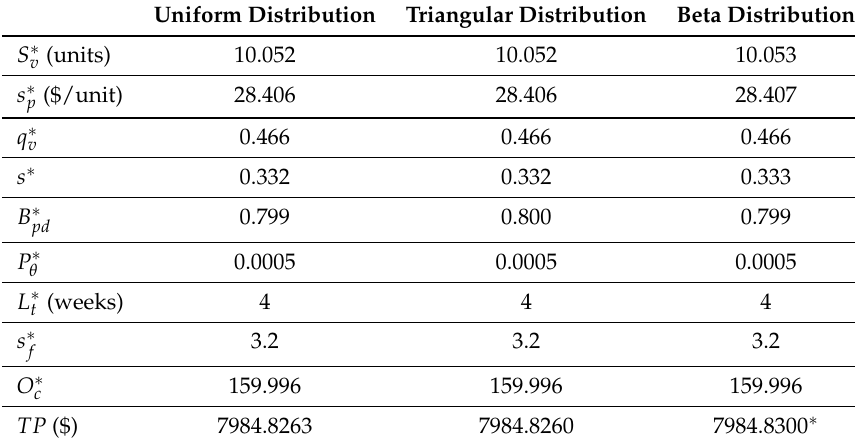
Table 3. Optimum Values without Service